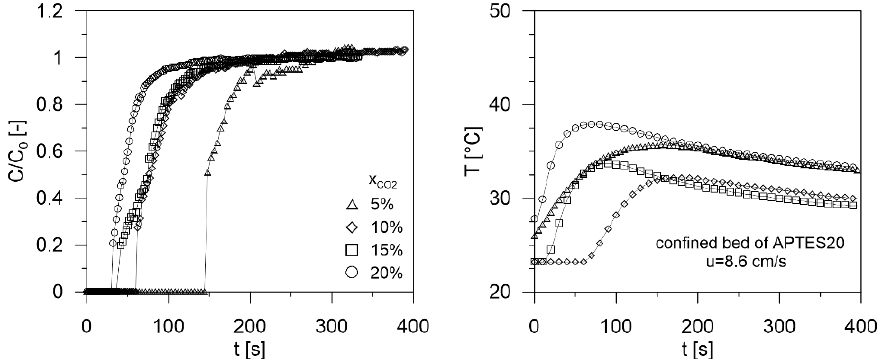
Figure 12. Breakthrough curves and corresponding temperature at different CO 2 concentrations for APTES20 in confined expanded bed at u = 8.6 cm/s.